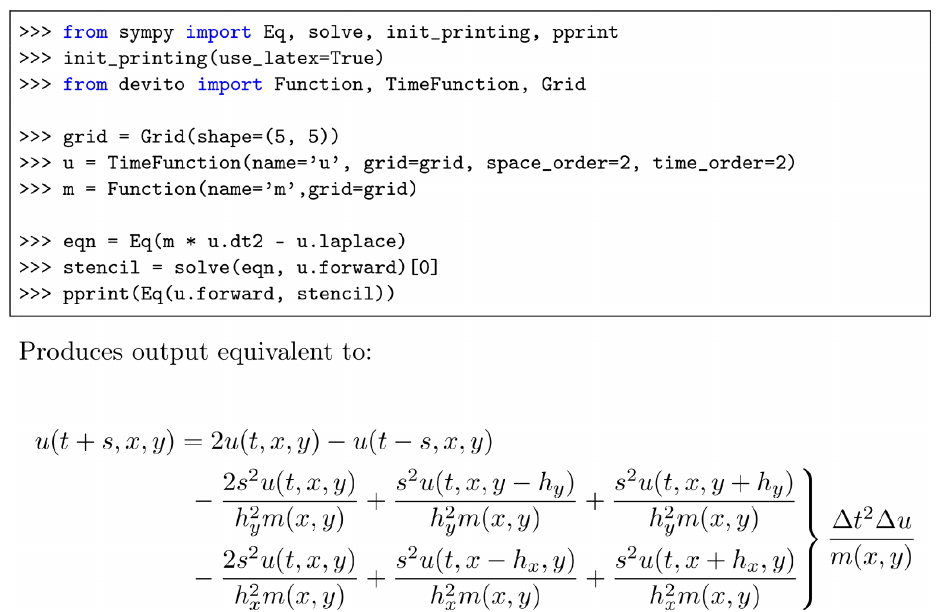
Figure 3. Example code defining the two-dimensional wave equation without damping using Devito symbols and symbolic processing utilities from SymPy. Assuming h x = (cid:49)x, h y = (cid:49)y , and s = (cid:49)t , the output is equivalent to Eq. (1) without the source term q s .